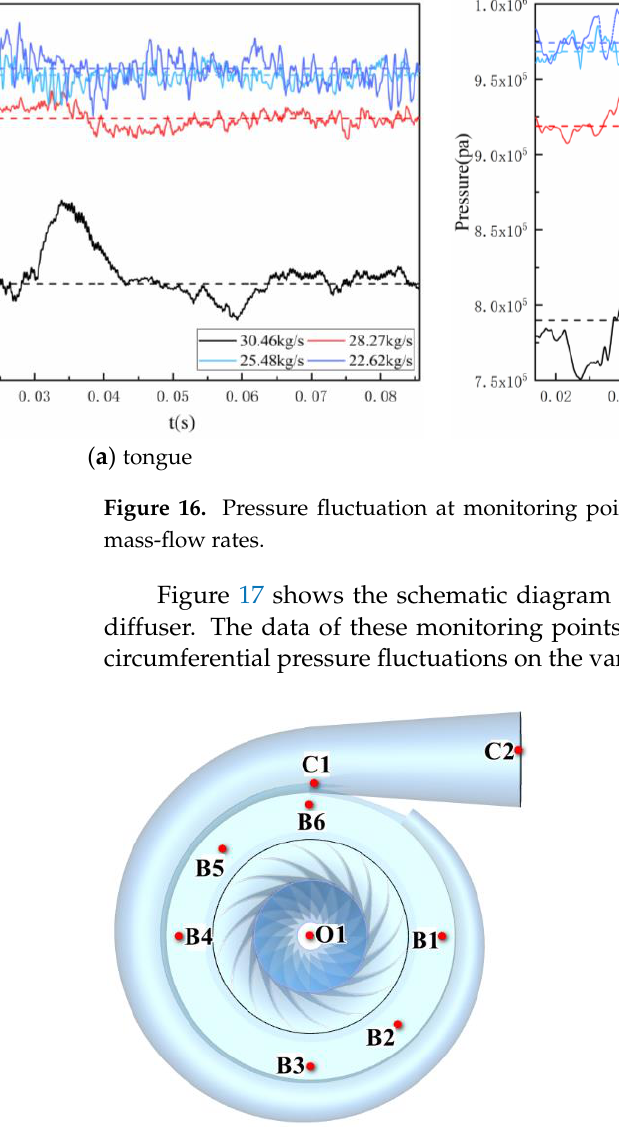
Figure 17. Monitoring points in the vaneless diffuser.